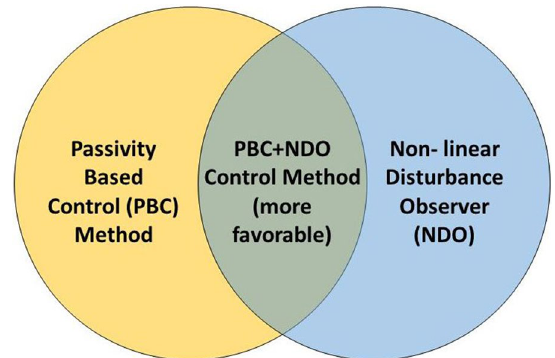
Fig. 8 Venn diagram of PBC